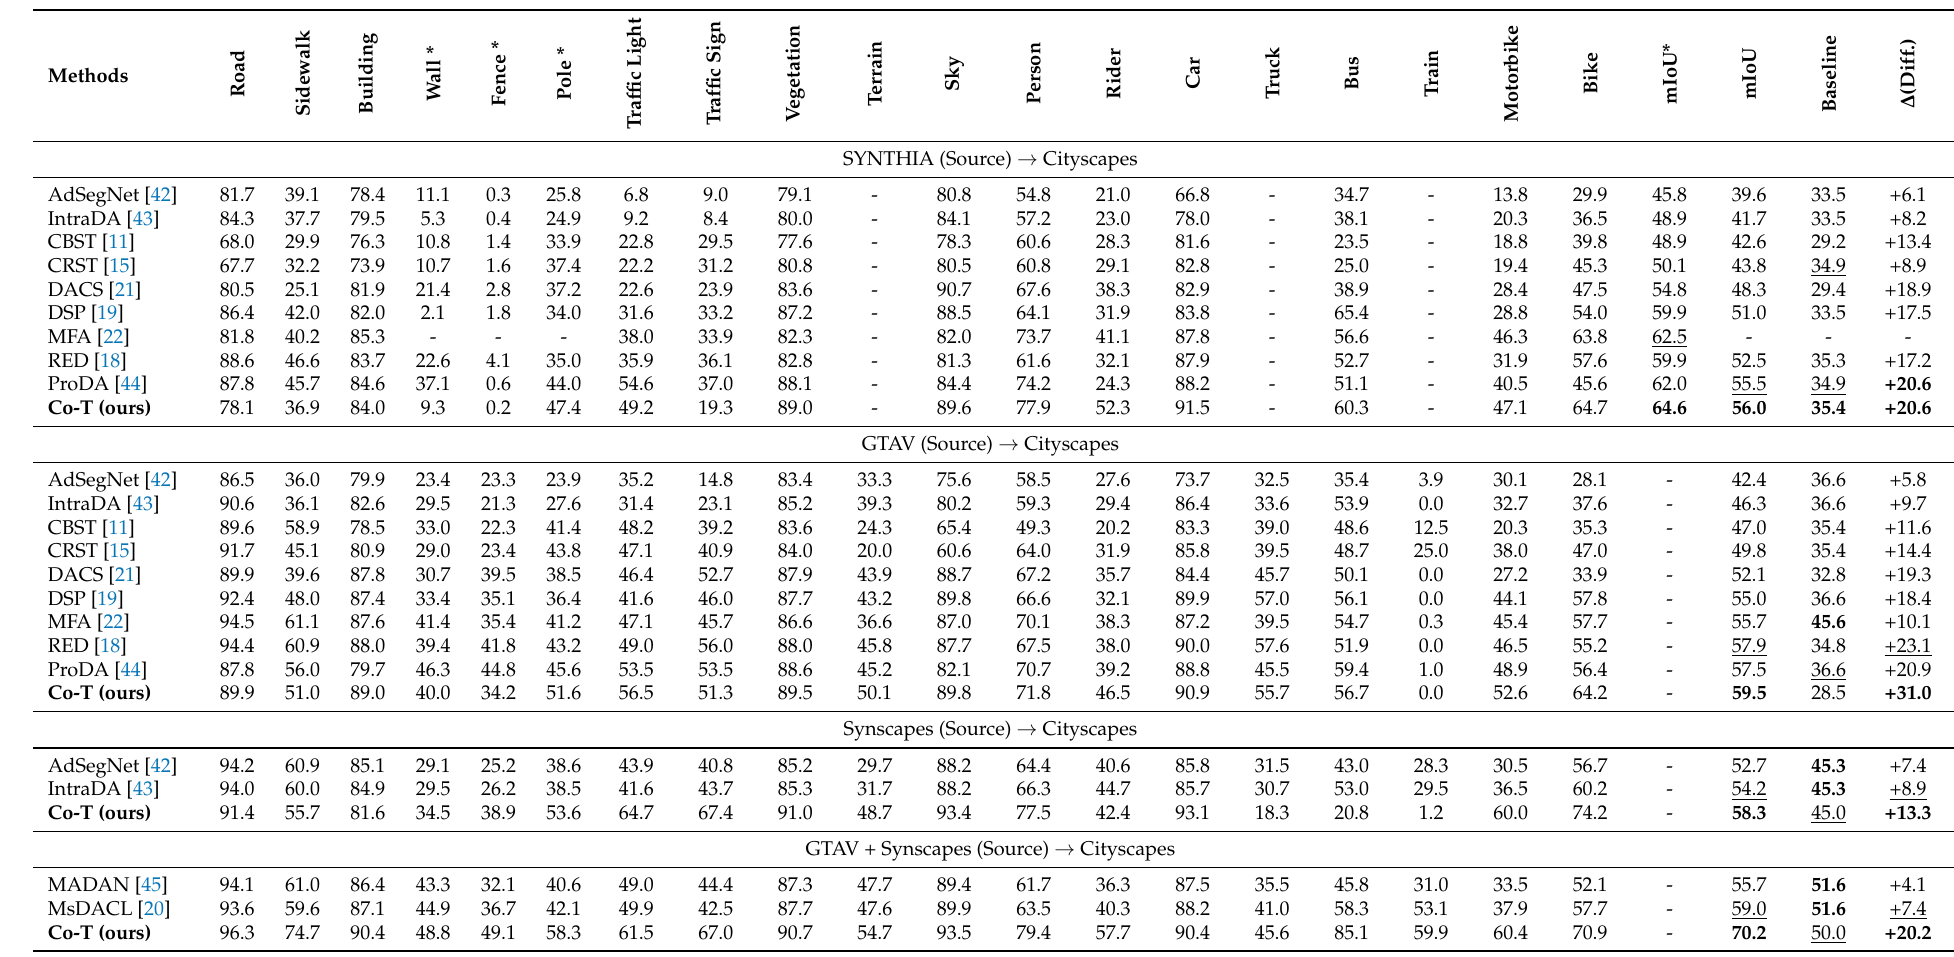
Table 1. UDA results. mIoU considers the 19 classes. mIoU* considers 13 classes, which only applies to SYNTHIA, where classes with ’*’ are not considered for global averaging and those with ’-’ scores do not have available samples. ∆ (Diff.) refers to the mIoU improvement over the corresponding baseline (i.e., column ’mIoU’—column ’Baseline’). Note also that, following Cityscapes class naming, the class Person refers to pedestrians (i.e., it does not include riders. Bold stands for best, and underline for second best. In this table, the target domain is always